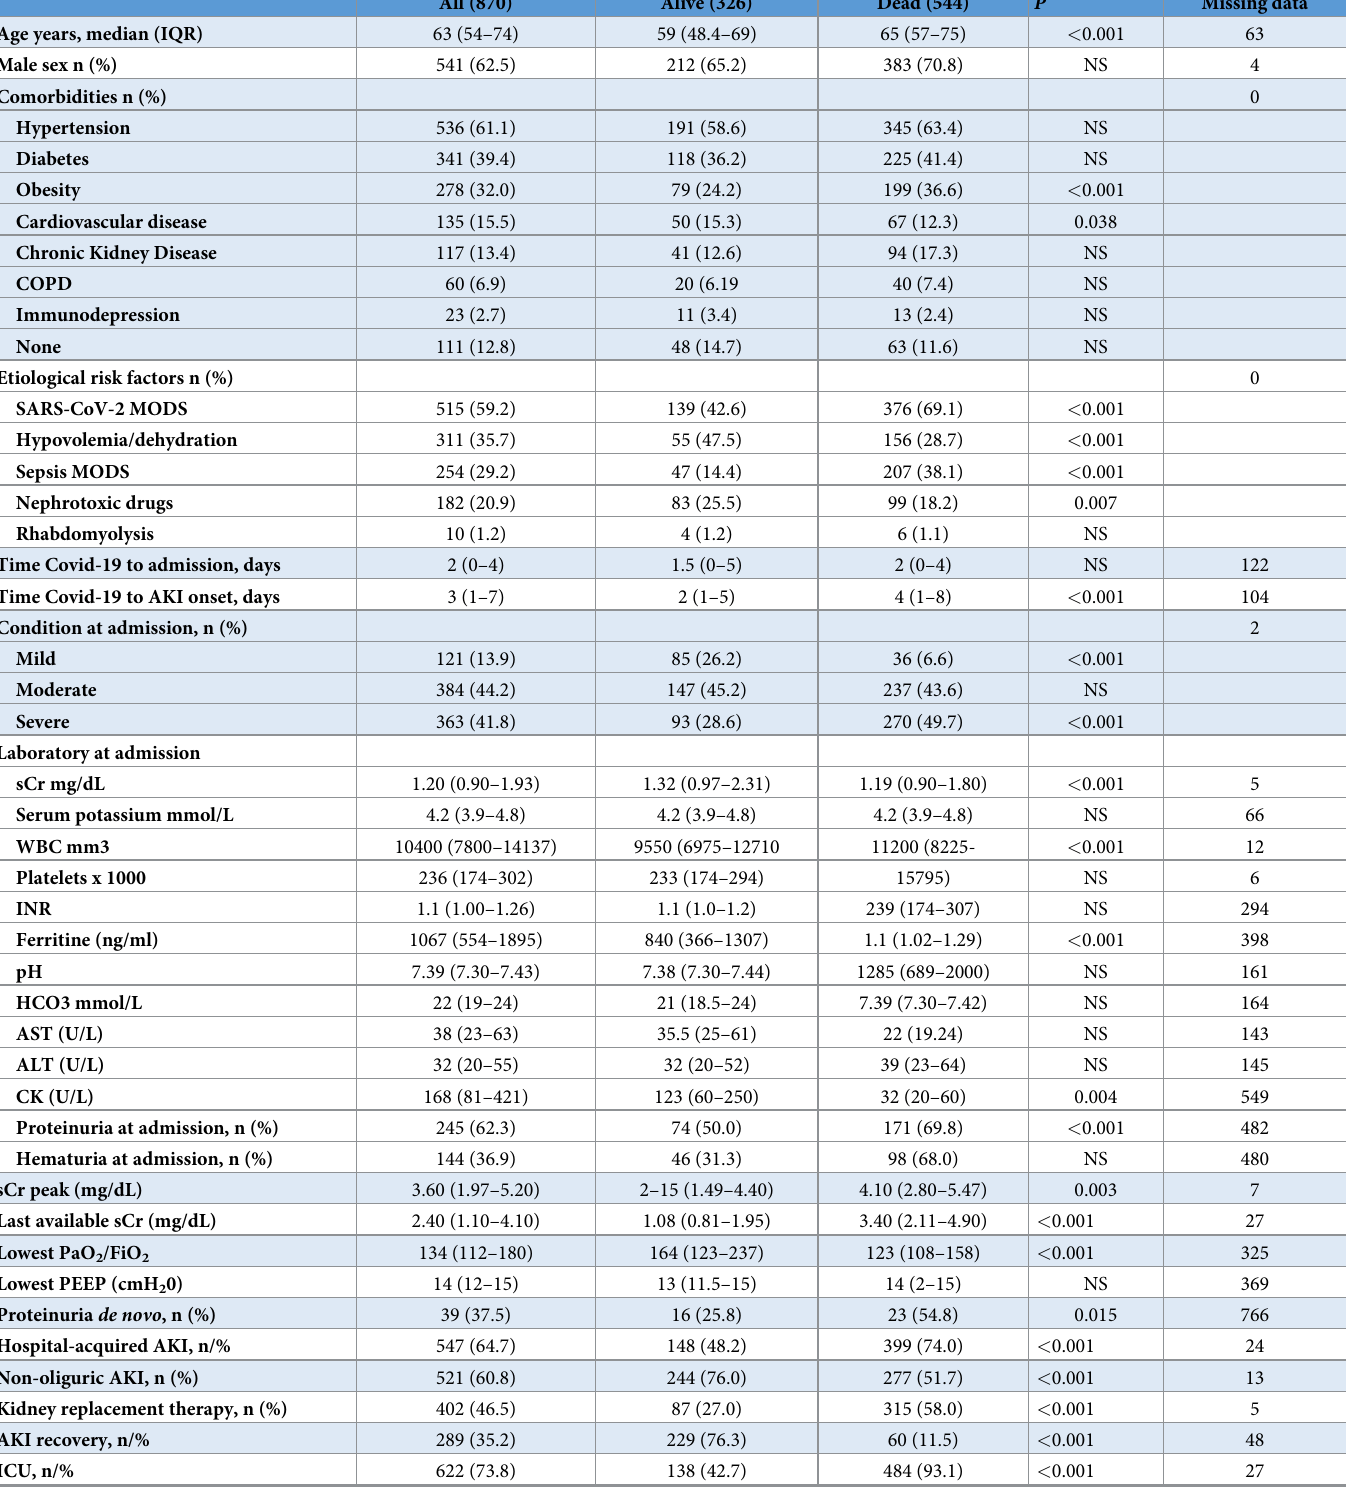
Table 1. Baseline data, outcome and missing data for variables of general